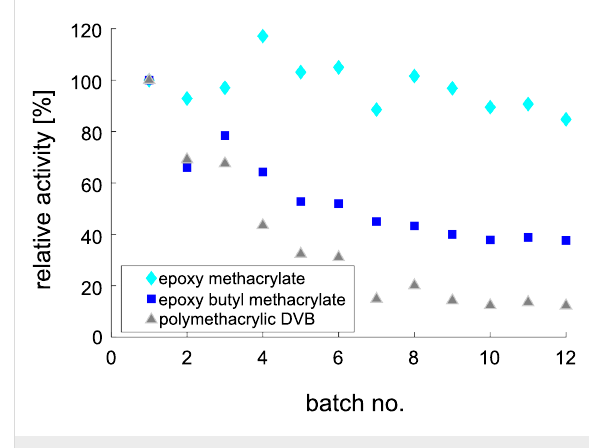
Figure 5: Relative activities in repetitive batch experiments of the immobilized epimerase on polymethacrylate DVB, epoxy methacrylate and epoxy butyl methacrylate. Reaction conditions: 40 °C, pH 8, 100 mM Tris, U shaker = 1400 rpm, V = 1 mL, immo epimerase 1%